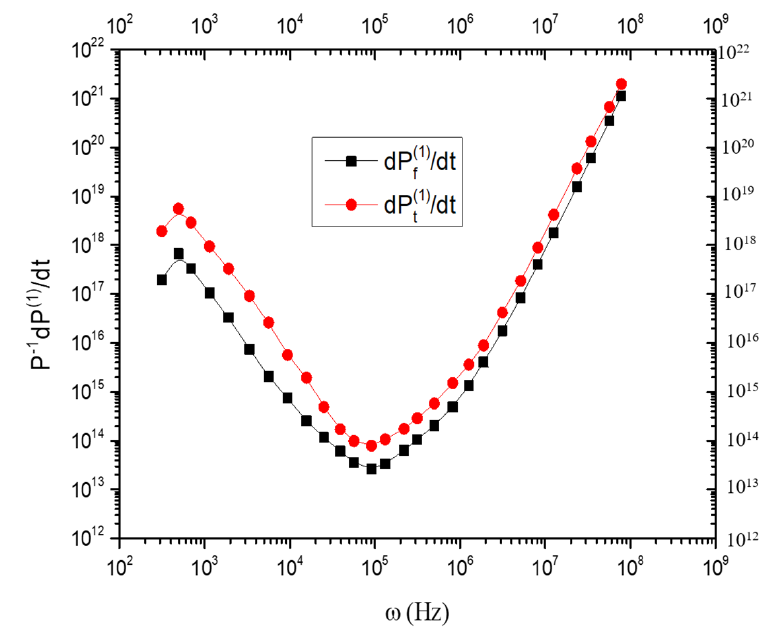
Figure 2. Comparison between normal (black line) and cancerous cells (red line) of the displacement current as a function of frequency, see Equations (A6), (A8) and (A16).